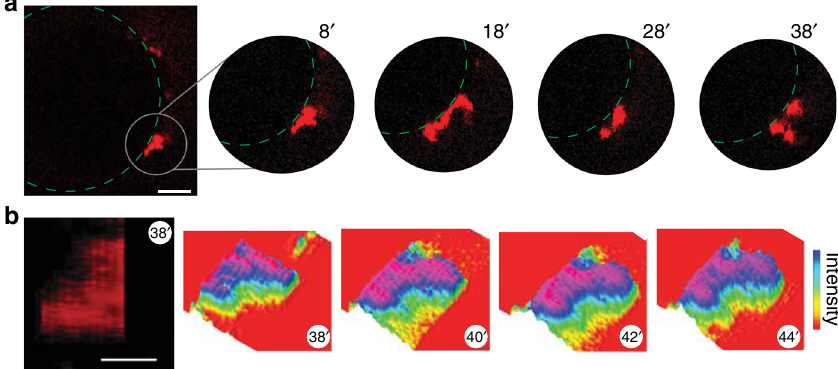
Fig. 5 IAPP oligomers are dynamic. Confocal fl uorescence imaging of 50 μ M IAPP doped (500:1) with IAPP A594 and applied to 5 μ M GPMV. Solution conditions are matched to those used for FRET studies (Fig. 8). a A representative z -slice of a GPMV showing a region of interest (ROI) that contains an oligomer. Imaging at 10 ′ intervals show evolution in oligomer structure. Green dashed lines indicate the location of the GPMV surface. b Three-dimensional reconstruction of one oligomer from a narrow ROI near the equatorial plane and several neighbouring z -planes. The reconstructed image has been rotated to show the oligomer from a perspective normal to the plane of the GPMV. Example of raw fl uorescence is shown (left) followed by colour coded intensity over a series of four time points at 2 ′ intervals. Scale bar for all images is 20 μ m